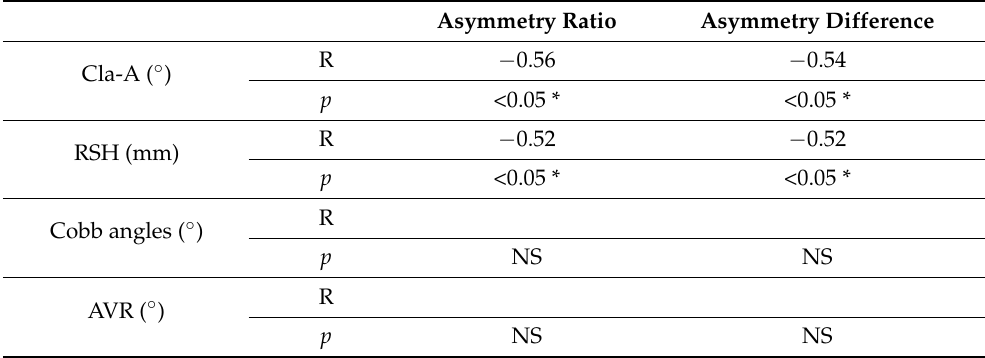
Table 2. Correlations between asymmetry in skeletal muscles of the upper arm and coronal parame- ters in group 1A.